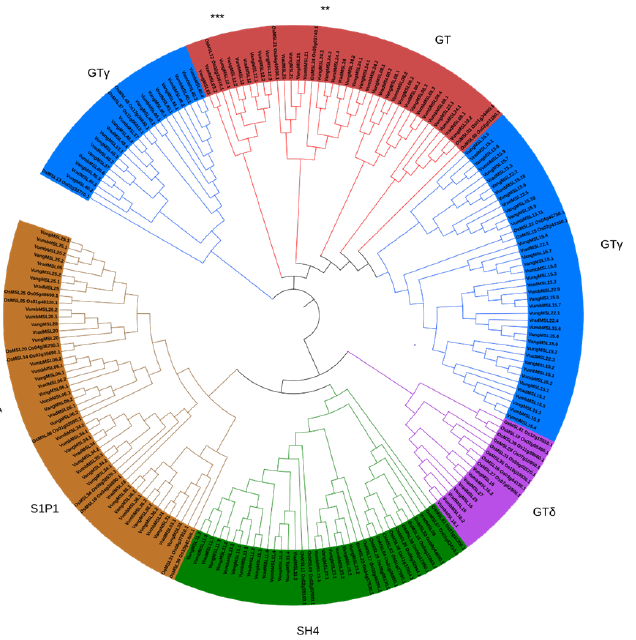
Figure 1 . Phylogenetic tree based on protein sequence of trihelix genes in cowpea, mung bean, adzuki bean, rice bean and rice. The maximum likelihood tree was created using MEGAX (bootstrap value = 1000). Vung, V. unguiculata ; Vrad, V. radiata ; Vang, V. angularis ; Vumb, V. umbellata ; Os, Oryza sativa . MSL, Myb/SANT-LIKE. The clade in red represents GT family, blue represents GT γ family, brown represents S1P1 family, green represents SH4 family and magenta represents GT δ family. ‘*’, ‘**’ and ‘***’ represent member of GT, GT γ and SH4 family clustered